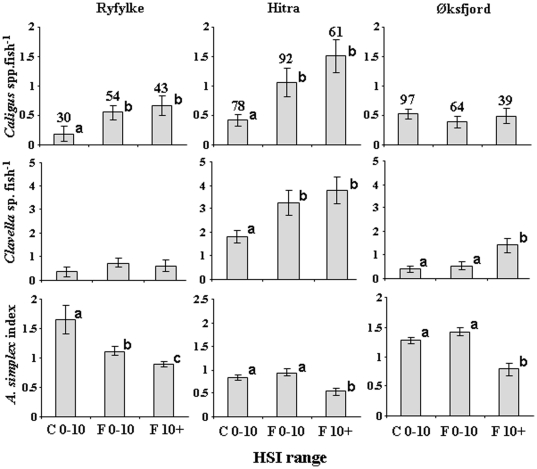
Mean abundances (± SE) of common parasites of saithe Pollachius virens in fish with a hepatosomatic index (HSI)<10 taken from non-farm locations (UA), and fish with HSI<10 and HSI>10 captured in association with Atlantic salmon farms (FA) in the three intensive fish farming areas.HSI = Hepatosomatic index. Superscripts (a,b,c) indicate a significant difference was detected among the groups at the p<0.05 level. Numbers above bars give the number of fish sampled for each comparison.